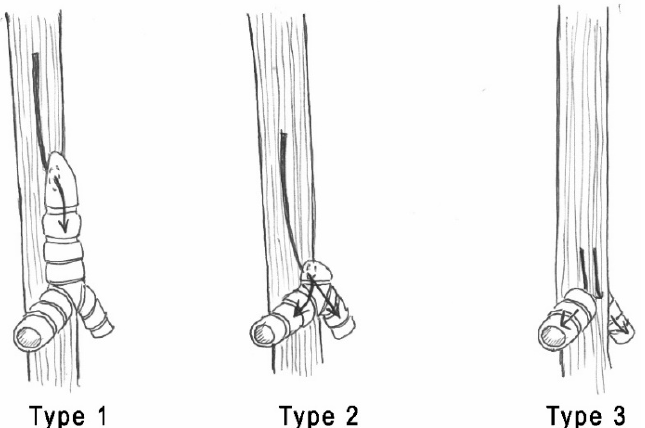
Figure 1. Floyd classification: ( Type 1 ) The proximal trachea is atretic, the carina is normal, and the distal tracheal segment is connected to the esophagus through a fistula; ( Type 2 ) the trachea is absent, and the main bronchi join at the carina. A carino-esophageal fistula is almost inevitably present; ( Type 3 ) the trachea and the carina are missing, and the main bronchi directly join the esophagus. Faro et al. later proposed an alternative classification, including seven different categories, as shown in Figure 2 [8,9].